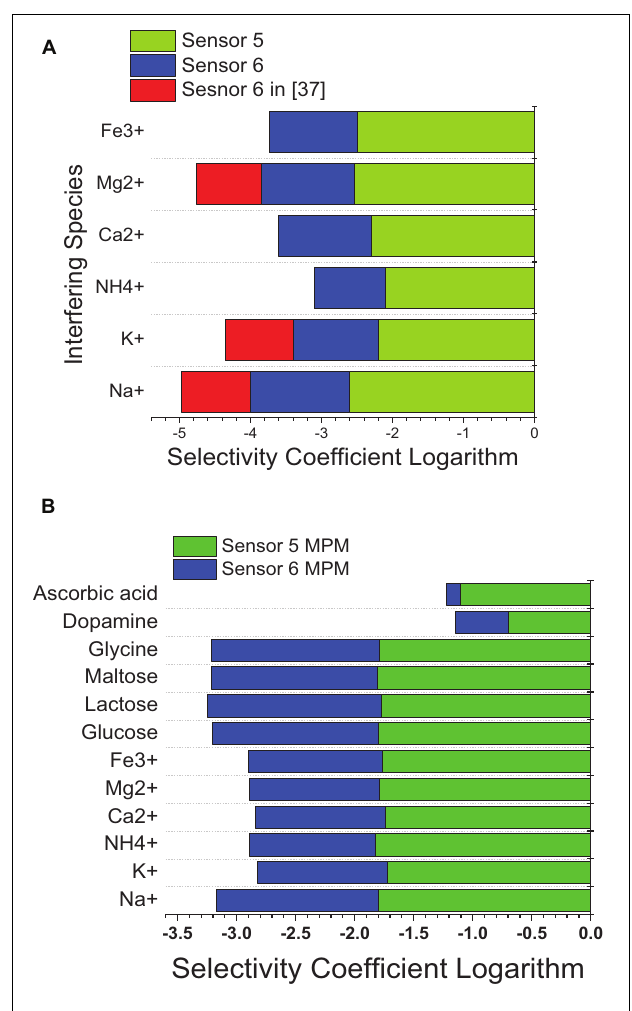
FIGURE 10 | Selectivity coefficient values of sensor 5 and sensor 6 from this work against sensor 6 in reference (Abo-Talib et al., 2015) against different interfering species calculated by (A) the SSM method and (B) the MMS